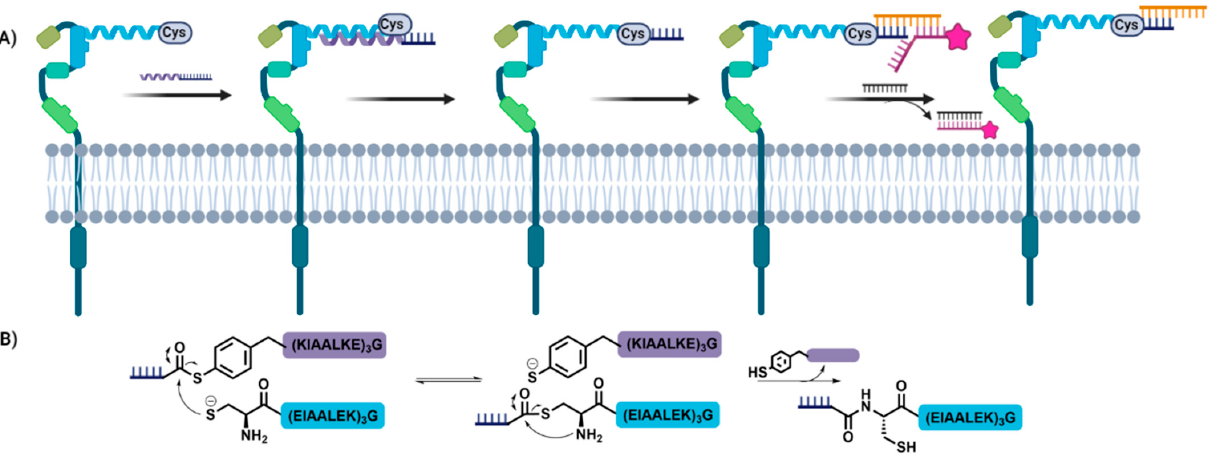
Figure 6. Case Study 3: Coiled-coiled templation for live-cell imaging. ( A ) Coiled-coil templation allows for site specific conjugation of an oligonucleotide to a membrane protein via native chemical ligation ( B ).